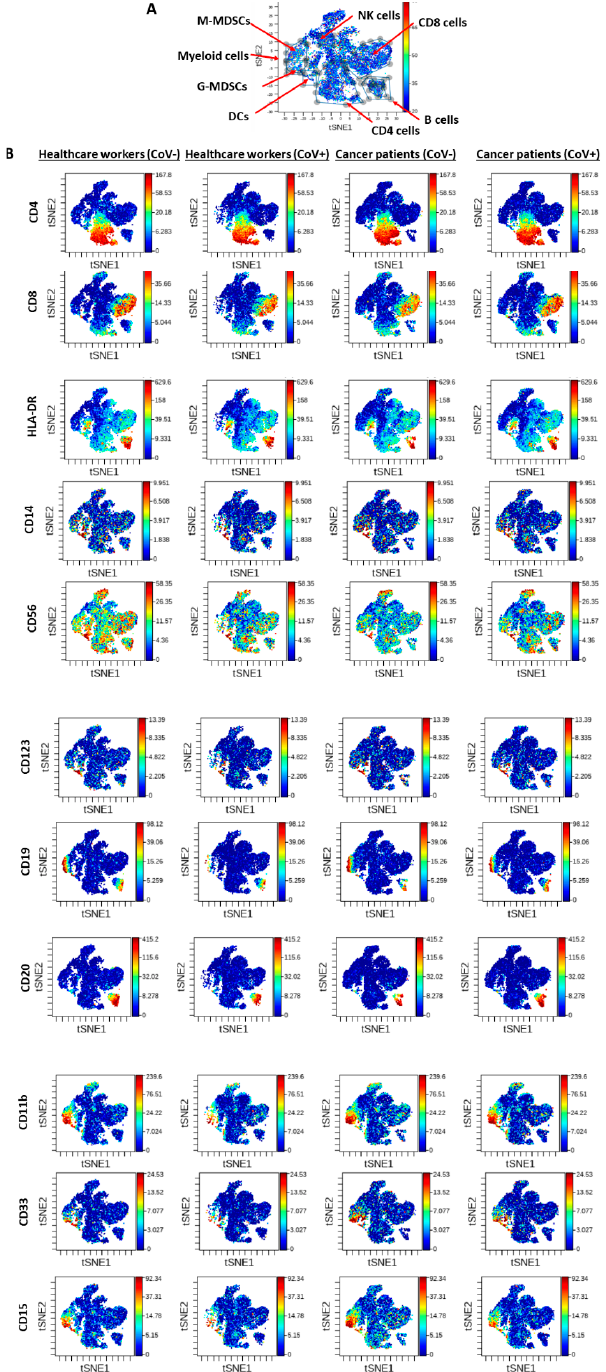
Figure 3. Immune composition of healthcare workers and cancer patients who are COVID19-positive or -negative. Peripheral blood samples from healthcare workers negative to SARS-CoV-2 IgG (CoV − , n = 6) or positive to SARS-CoV-2 IgG ( n = 2) as well as cancer patients who were SARS-CoV-2 IgG-negative and -positive ( n = 2 for each group, matched individuals) were acquired by mass cytometry (CyTOF). The samples were then grouped as indicated in the figure, and the percentages of various immune cells were analyzed as shown in Table 3. ( A ) A representative viSNE plot of the di ff erent immune cell population detected. ( B ) The specific surface markers representing the di ff erent immune cells, as indicated in Table S4, are shown for the four groups. DCs: dendritic cells, M-MDSCs: monocytic myeloid derived suppressor cells, G-MDSCs: granulocytic myeloid derived suppressor cells. In the viSNE plot, red represents high expression whereas blue represents low or no